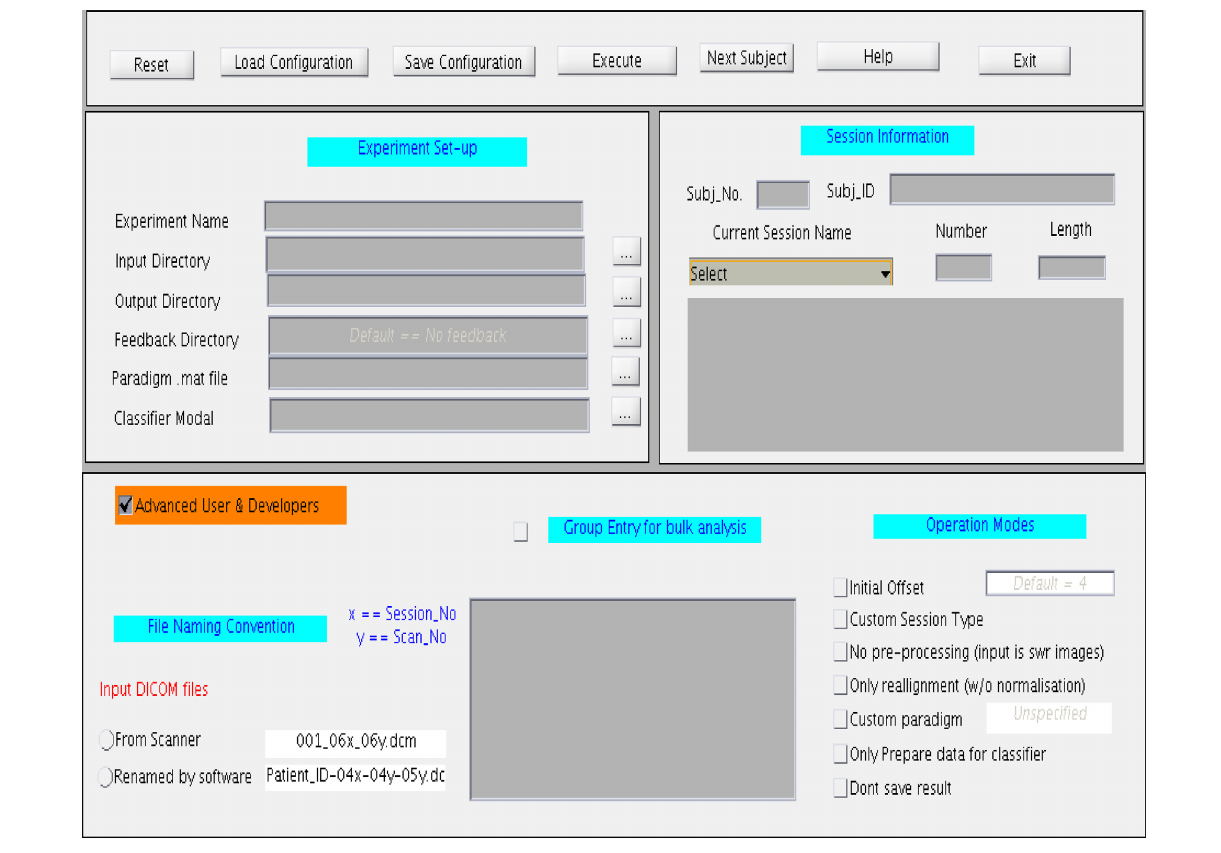
OFFLINE CLASSIFICATION OF BRAIN STATES OF